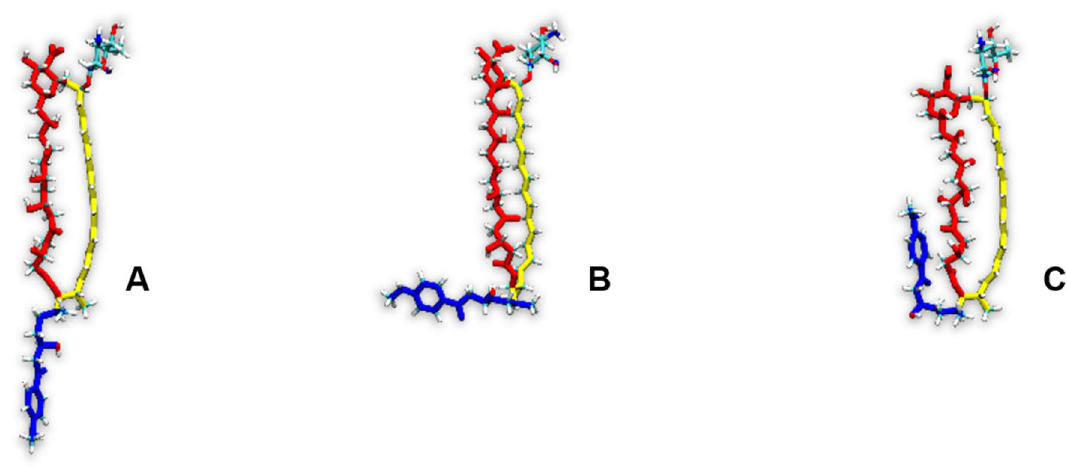
Figure 10. Orientation of an AHM’s alkyl-aromatic sidechain in relation to the rest of the molecule: ( A )— aligned; ( B )—bent; ( C )—tucked